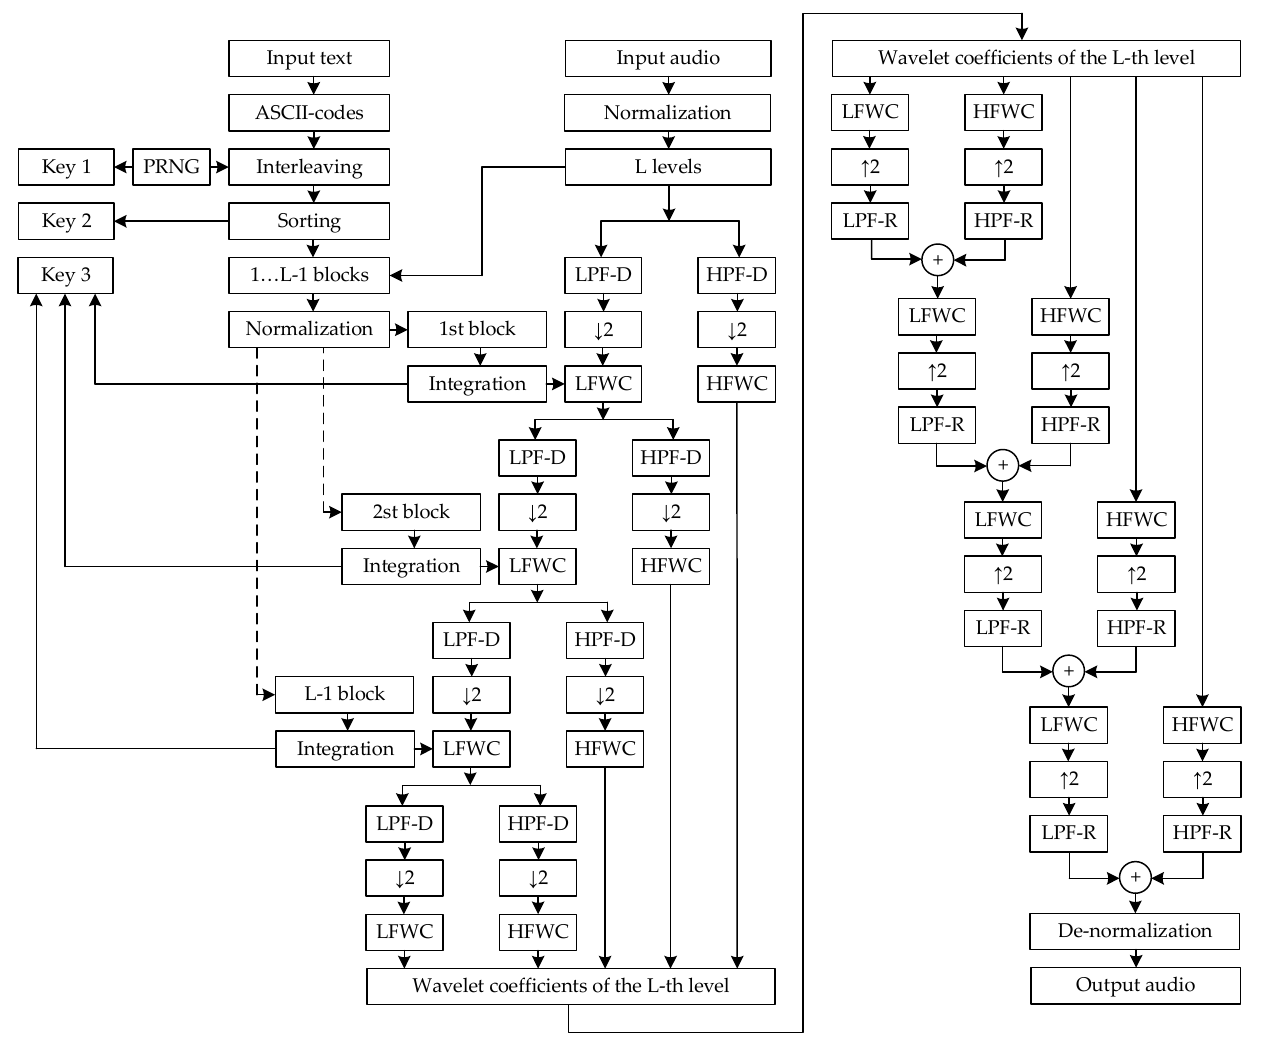
Figure 1. Structural diagram of the proposed method for integrating text information into an audio signal.